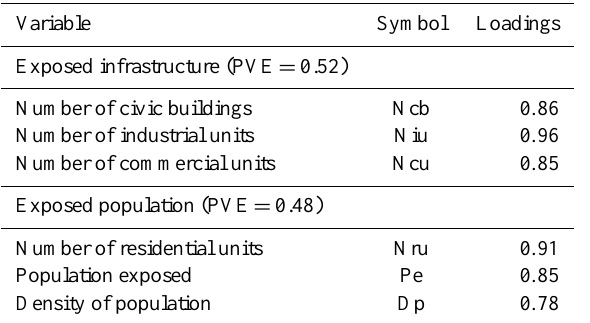
Table 6. Results of the principal component analysis physical sus- ceptibility indicators.